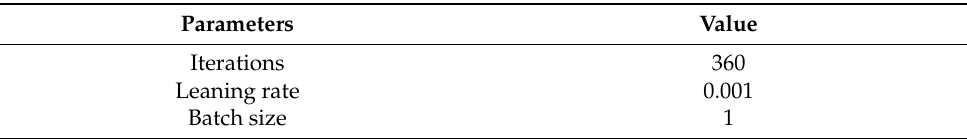
Table 9. Hyper-parameters for fine-tuned Mask